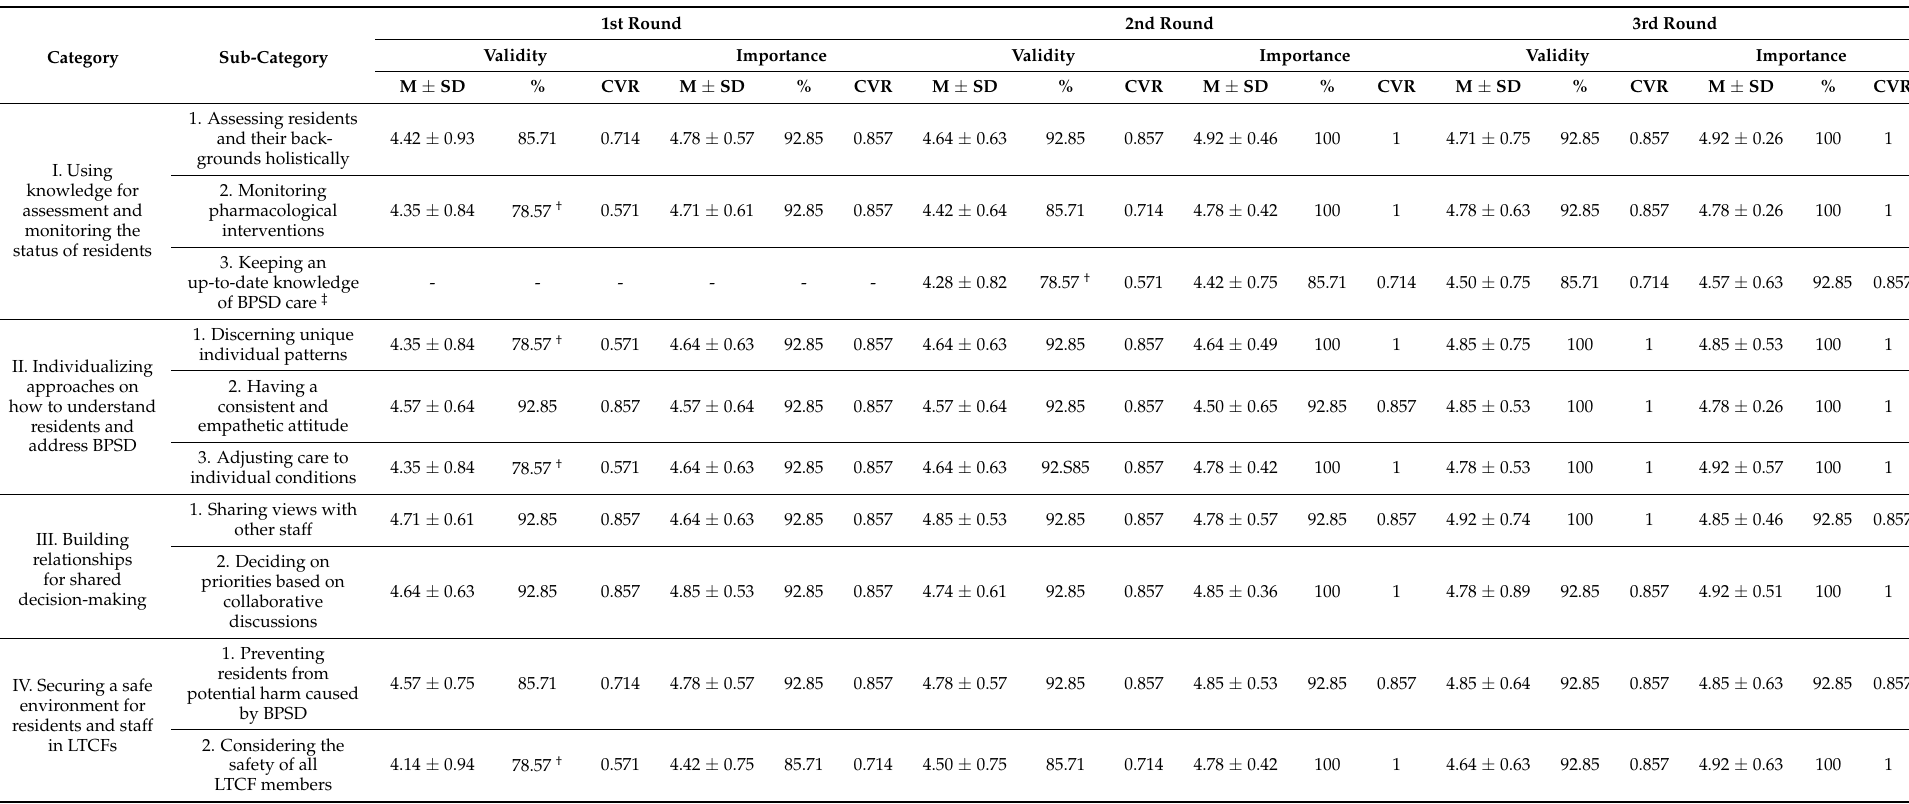
Table 3. Result of the Delphi